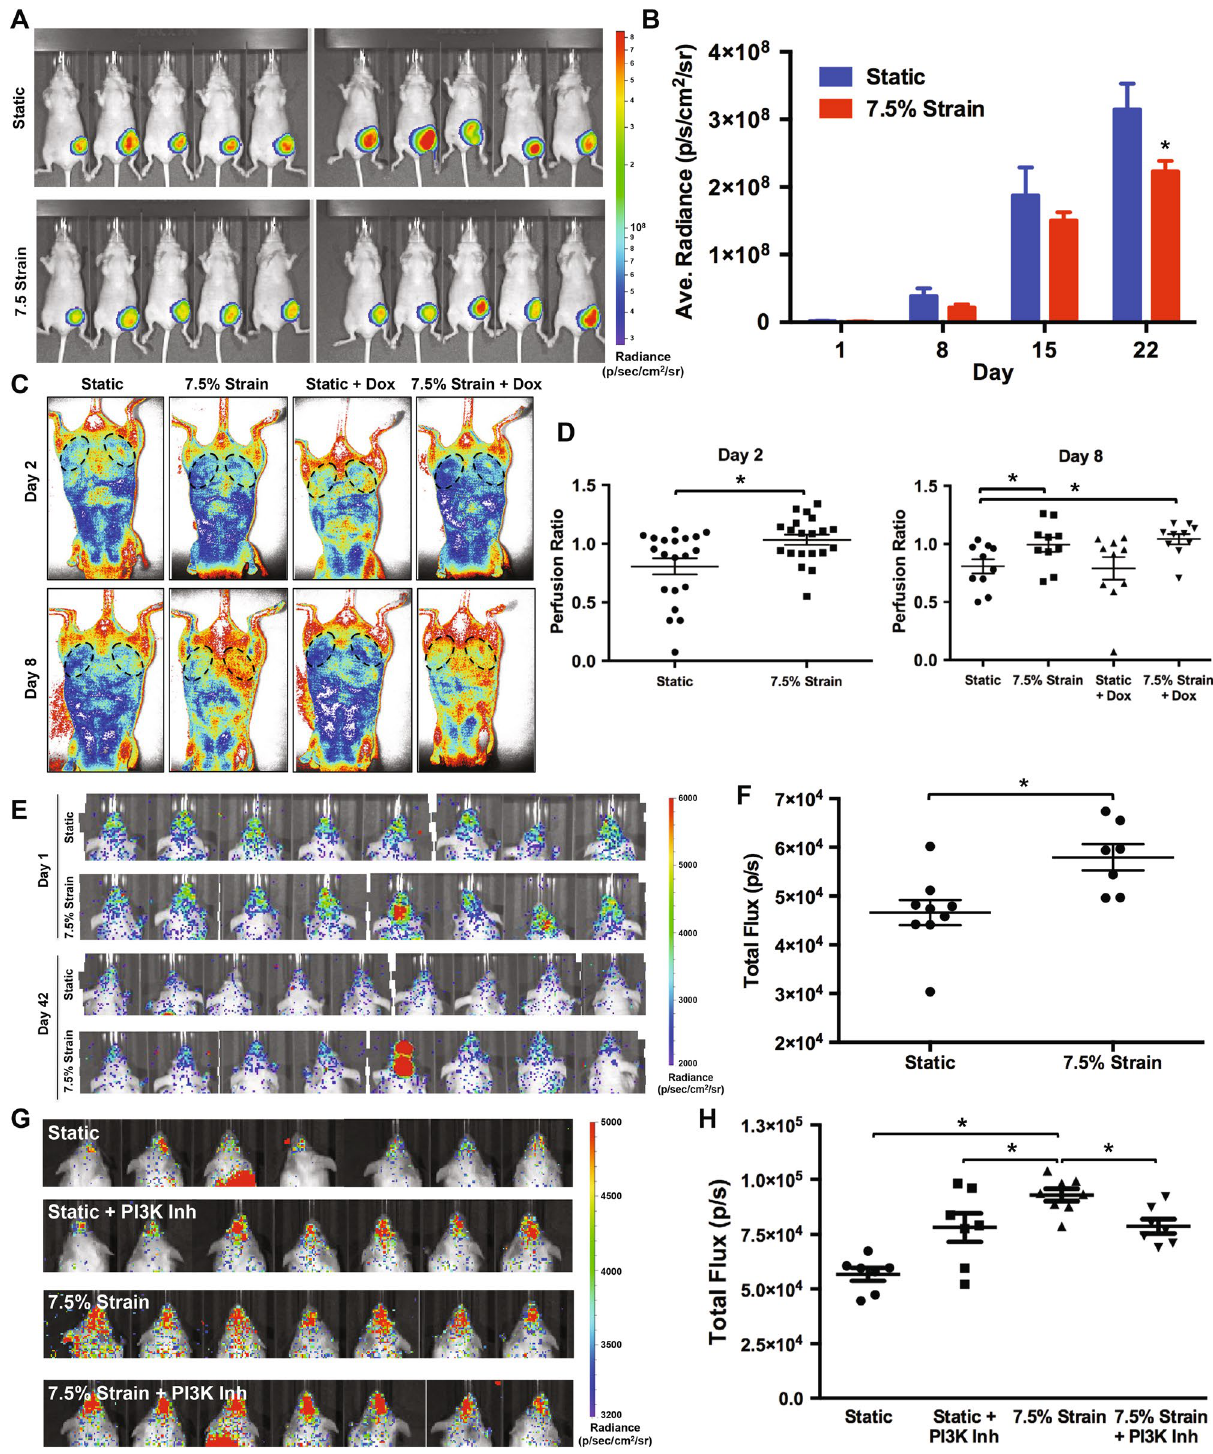
Figure 7. Mechanical loading decreases tumor growth and increases metastasis to the skull in immune compromised mice. ( A ) Luciferase expressing MDA-MB-231 cells were grown under static or mechanically loaded conditions for 24 h and then implanted into the mammary fat pad of nu/nu mice. Radiance of mice with orthotopic tumor implantation at 22 days. ( B ) Quantification of the radiance in the mammary fat pad. * p < 0.05 versus static group (n = 10). ( C ) Laser speckle imaging of mice with orthotopic implantation of MDA-MB-231 cells after mechanical conditioning. ( D ) Ratio of perfusion of the mammary fat pad with tumor implantation to contralateral control fat pad. * p < 0.05 between indicated groups (n = 10). ( E ) Images of luminescence as measured by IVIS for nu/nu given an intravenous injection of MDA-MB-231 cells. The cells were cultured under static or 7.5% strain for 24 h prior to injection. ( F ) Quantification of luminescence in the head of the mice given an intravenous injection of MDA-MB-231 cells at day 42 following injection. * p < 0.05 versus static group (n = 8–9). ( G ) Luminescence in the heads of NOD Scid mice 42 days after tail vein injection of MDA-MB-231 cells. ( H ) Quantification of the luminescence in the head of the mice after 42 days. * p < 0.05 versus indicated group (n =